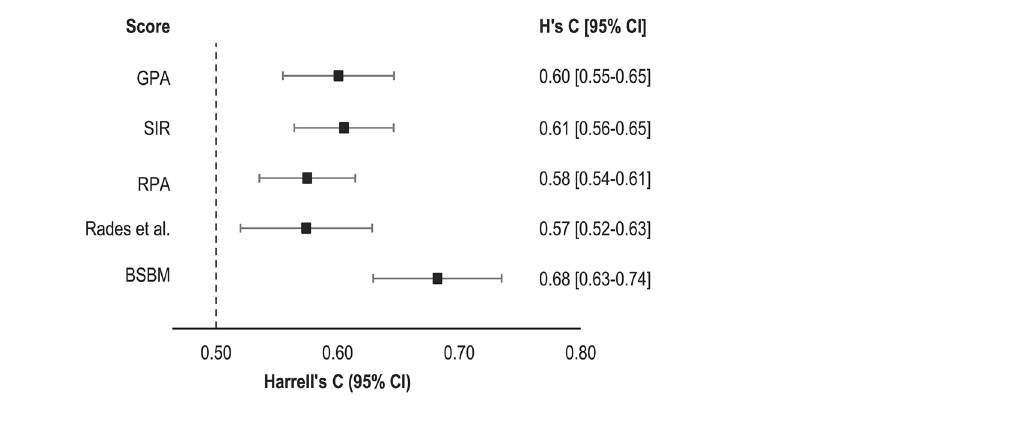
Figure 4. Comparison of prognostic indices using Harrell’s C.